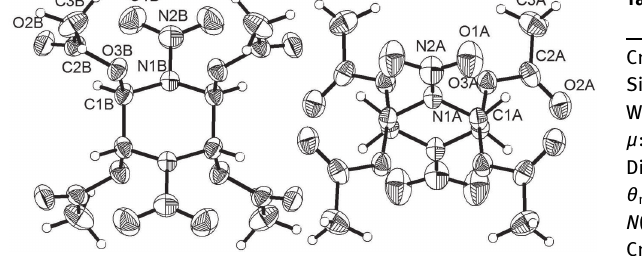
Table 1: Data collection and handling.